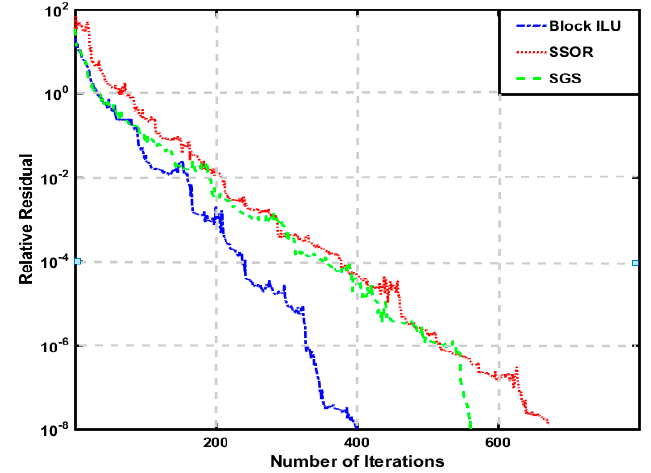
Figure 13. The convergence plot of different preconditioners with QMR for the model 3.